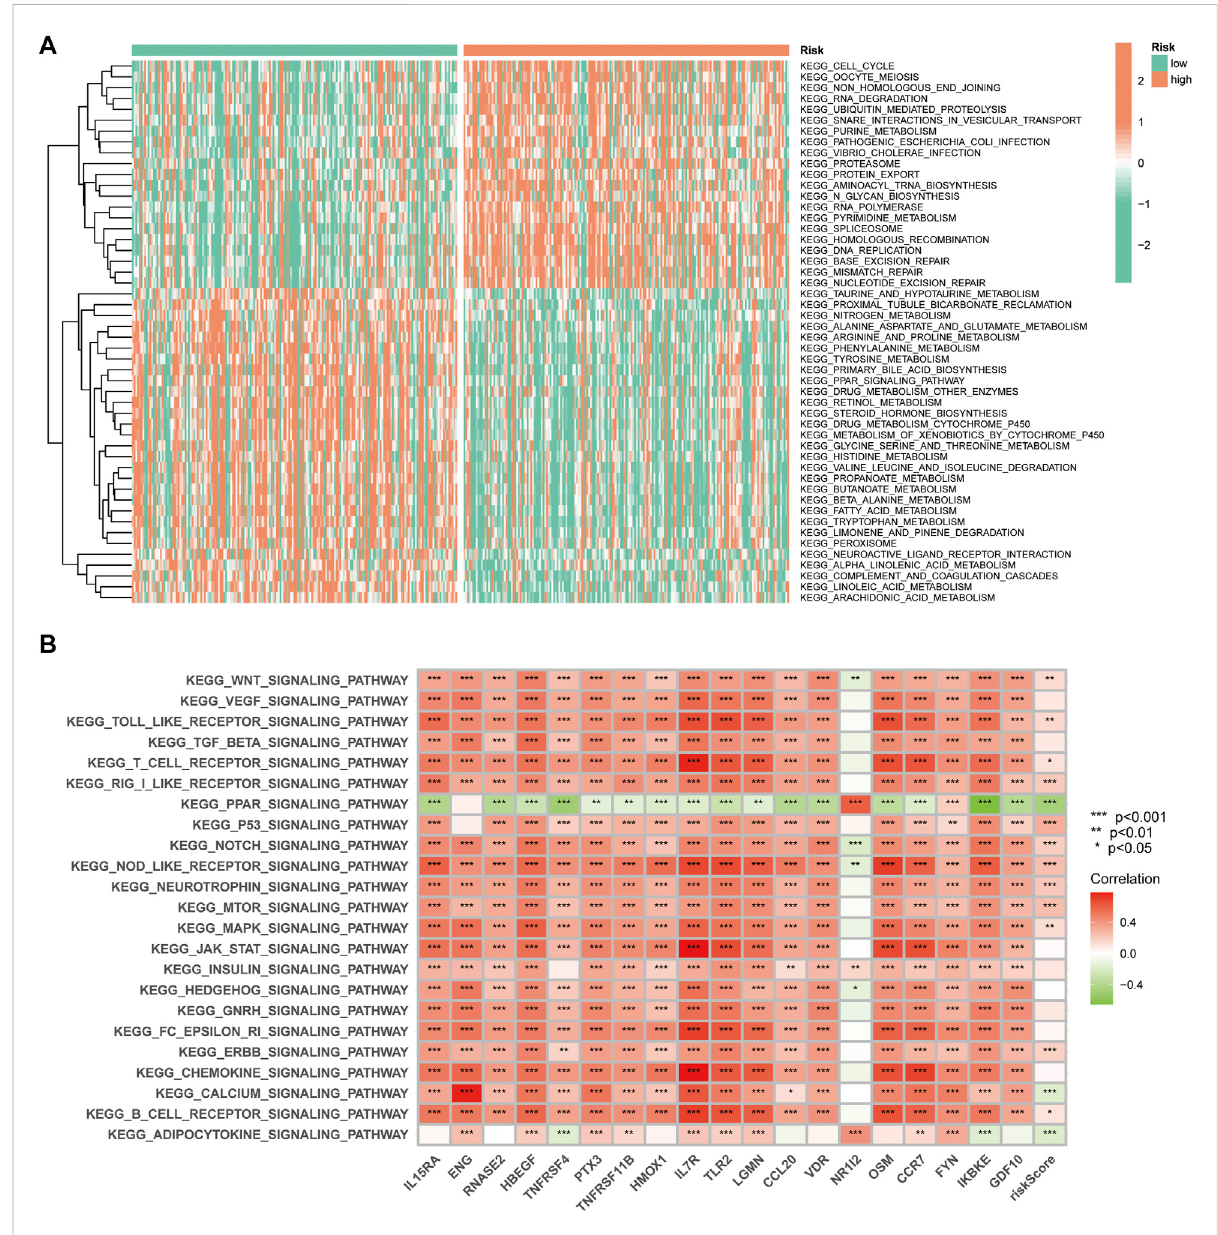
FIGURE 10 The Gene Set Variation Analysis. (A) Heat map highlighting the differences in functional pathways in the high- and low-risk groups. (B) The correlation between the KEGG pathway and signature gene mRNA